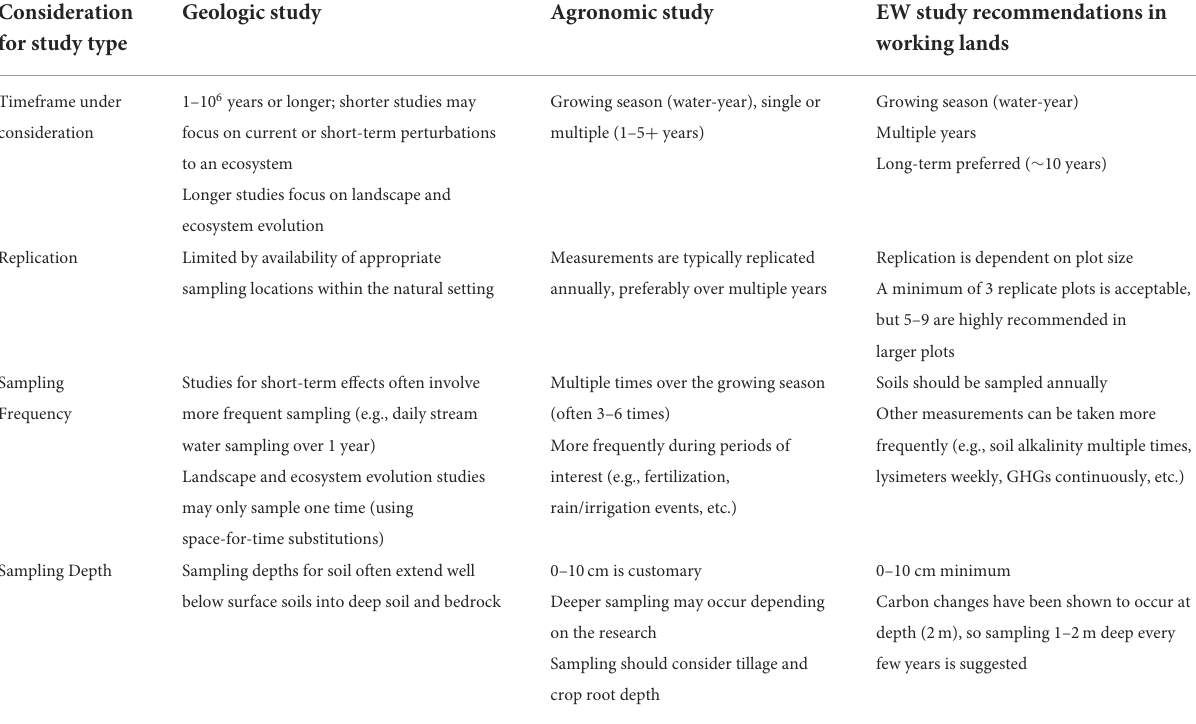
TABLE 3 Summary of the differences between geology and agronomy studies, and recommendations for geologic experimental designs in working